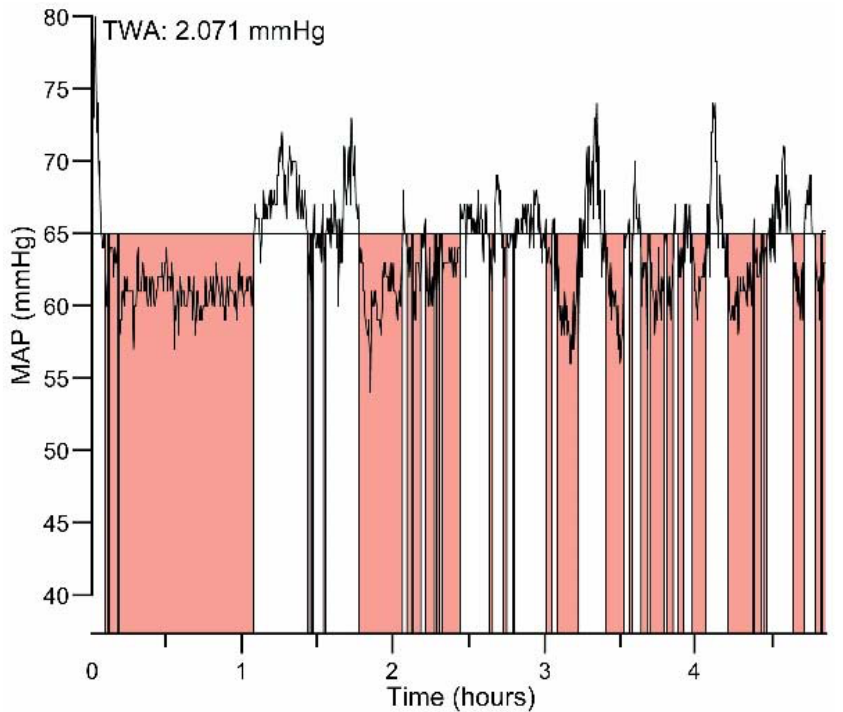
Figure 1. The area under the threshold to calculate the time ‐ weighted average of hypotension. Sub ‐ script Figure 1: This is an illustration of a first section measurement (5 h) of one individual patient from this study to indicate how the TWA is calculated.TWA = (depth hypotension below MAP threshold (in this case 65 mmHg) in mmHg × time spent below MAP 65 threshold in minutes. The time ‐ weighted average (TWA) in hypotension combines the time and depth of hypotension. To cal ‐ culate the TWA of hypotension the AUT is needed. The AUT is calculated as the ‘area of hypoten ‐ sion below the threshold—defined as a Mean Arterial blood Pressure (MAP) of 65 mmHg’ × ‘time spent below MAP 65 mmHg in minutes’. Subsequently the formula of TWA in hypotension is as follows: ‘AUT’/‘total duration of measurement period in minutes’.